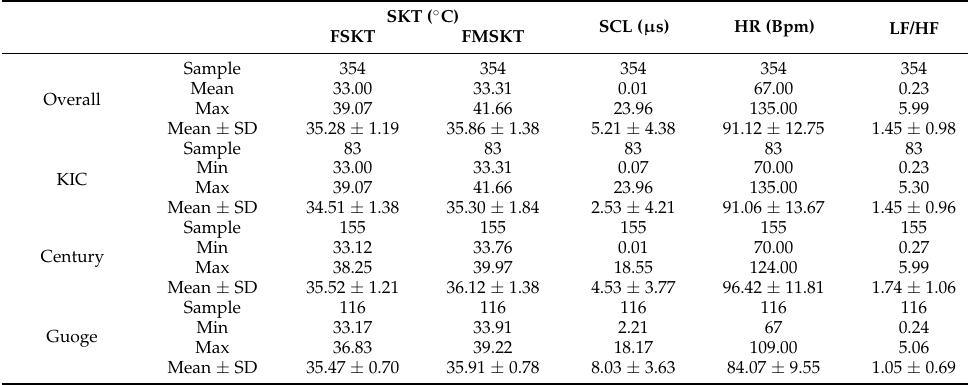
Table 3. Participants’ thermal physiology response during